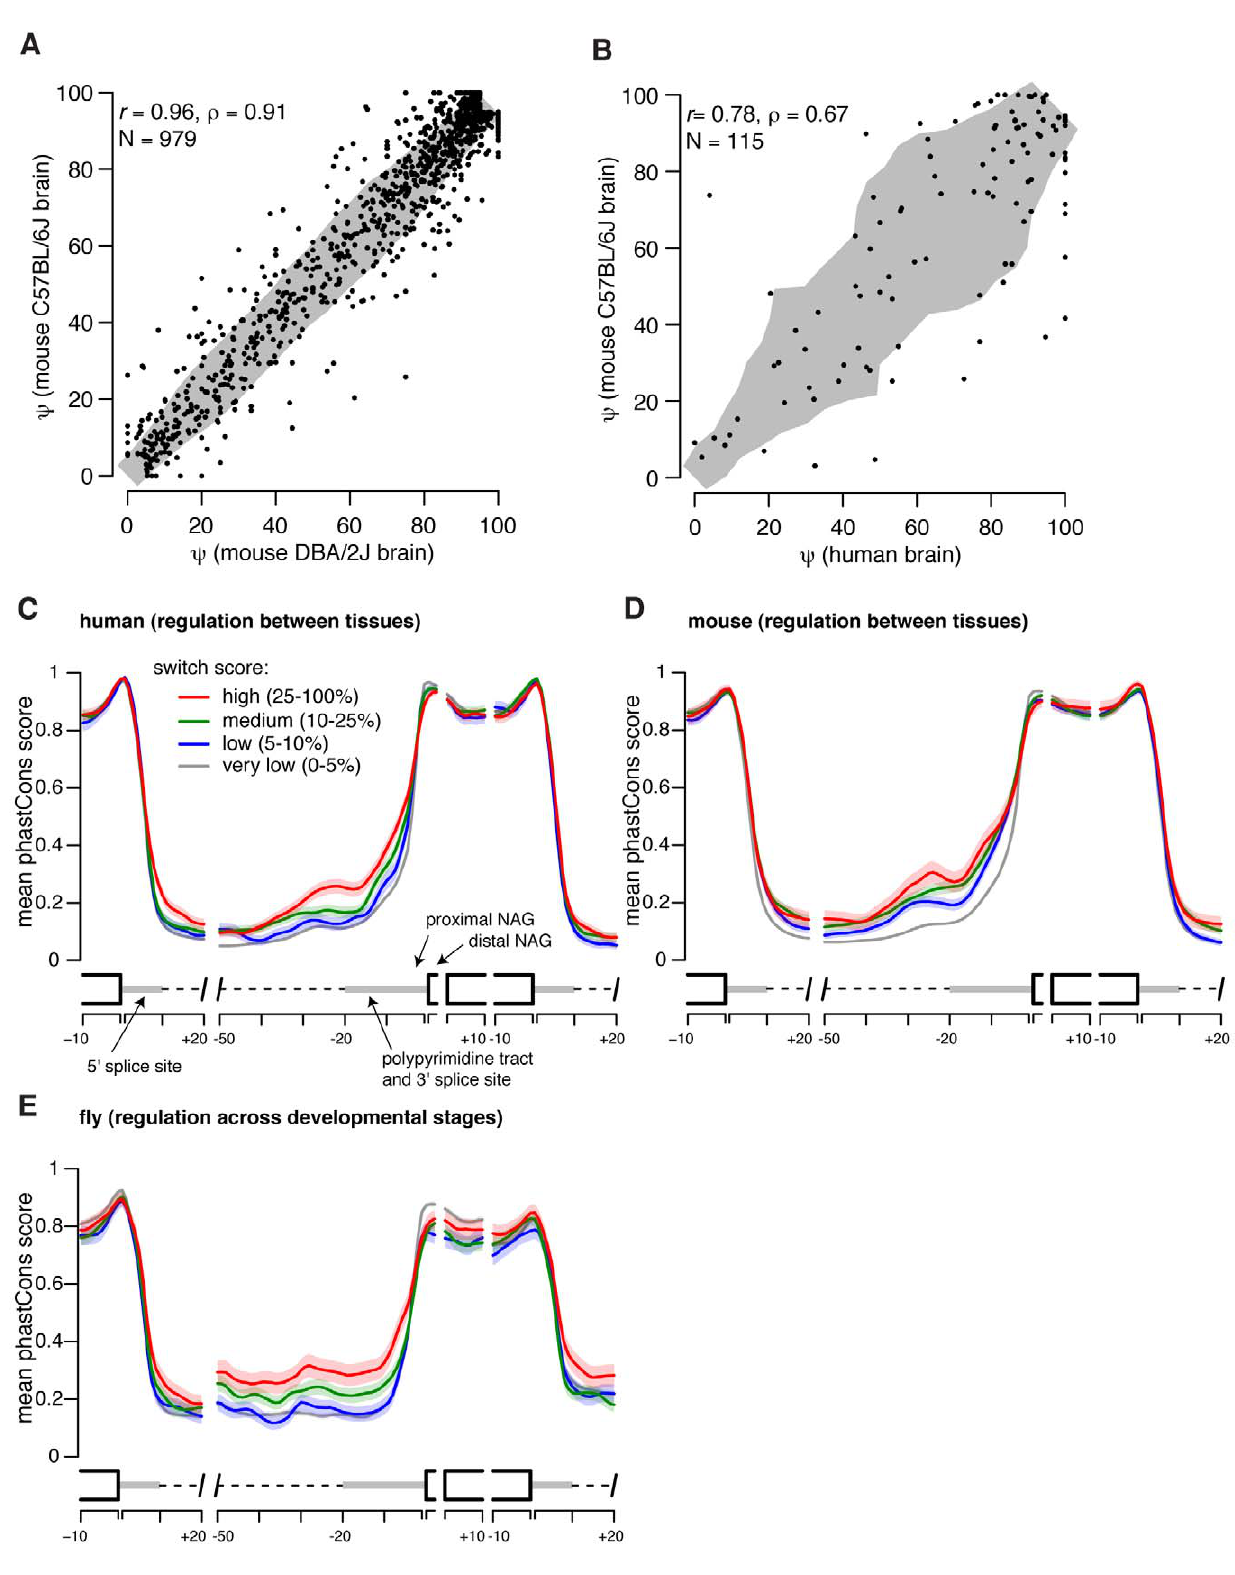
Figure 2. Increased sequence conservation upstream of tissue- and developmentally-regulated NAGNAGs. (A) NAGNAG y estimates are highly consistent in brain RNA-Seq data from the mouse strains DBA/2J and C57BL/6J. Only NAGNAGs with both isoforms expressed at $ 5% in either strain are shown. The 75 th percentile of the deviation from the line y=x is shown in gray. (B) NAGNAG y estimates are quantitatively conserved between human and mouse brain. Only NAGNAGs with both isoforms expressed at $ 5% in either species and satisfying |proximal 3 9 splice site score – distal 3 9 splice site score| # 0.5 bits are plotted (splice sites scored by MaxEnt model [36]). Deviation from y=x shown as in (A). (C) Sequence